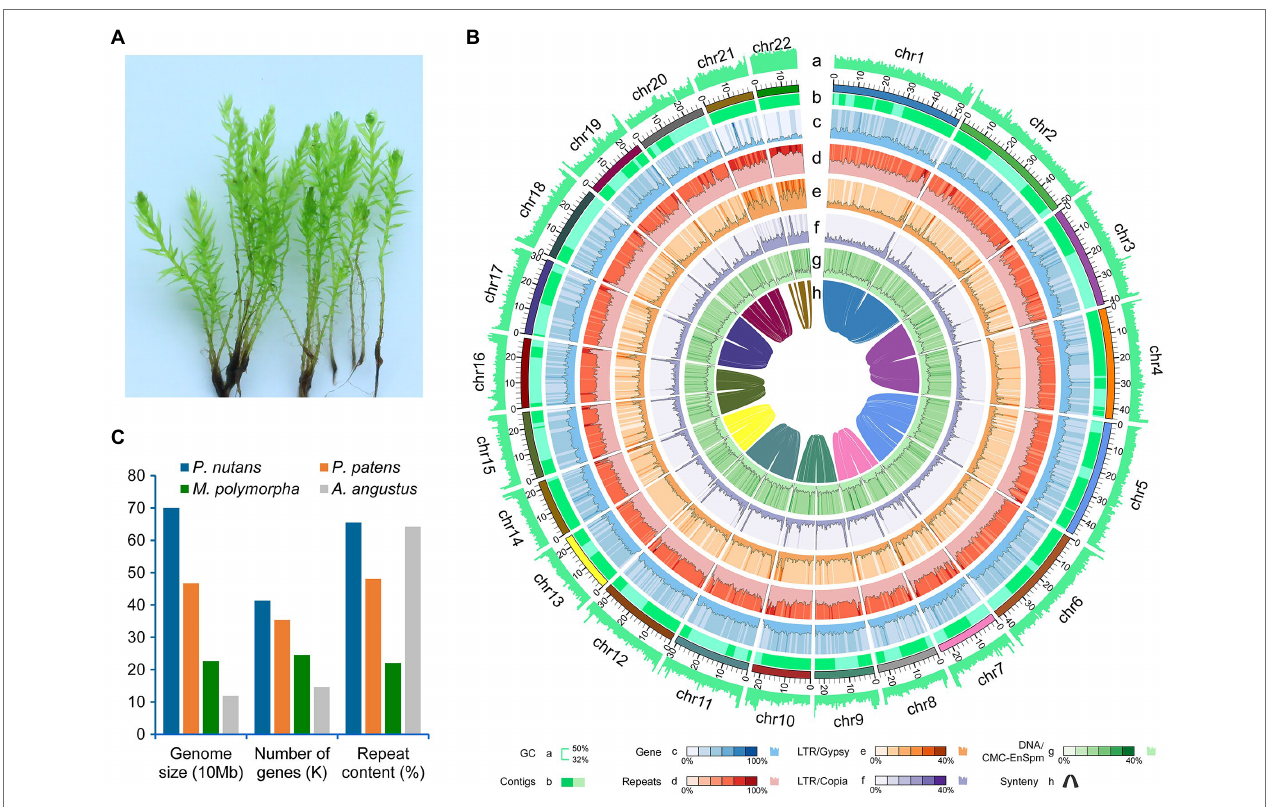
FIGURE 1 | Genomic structure of the Antarctic moss Pohlia nutans . (A) Photo of P. nutans under normal condition. (B) The landscape of genome assembly and annotation of P. nutans . Tracks from outside to inside correspond to: a, GC content; b, contigs density; c, gene density; d, repeat density; e, LTR/ Gypsy content; f, LTR/ Copia content; g, DNA/CMC-EnSpm; and h, syntonic relationship. (C) The genome size, gene content, and repeat content of four bryophyte genomes (the Antarctic moss P. nutans , the moss model plant Physcomitrella patens , the liverwort model plant Marchantia polymorpha , the hornwort model plant Anthoceros angustus ).